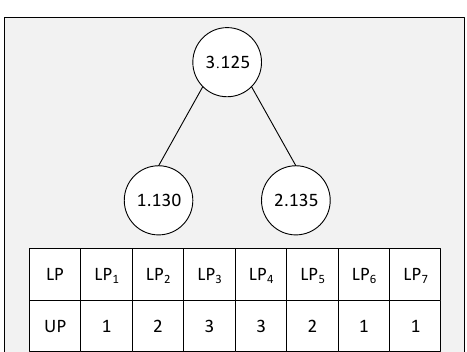
Figure 6. Final min-heap and partition query table (PQT).